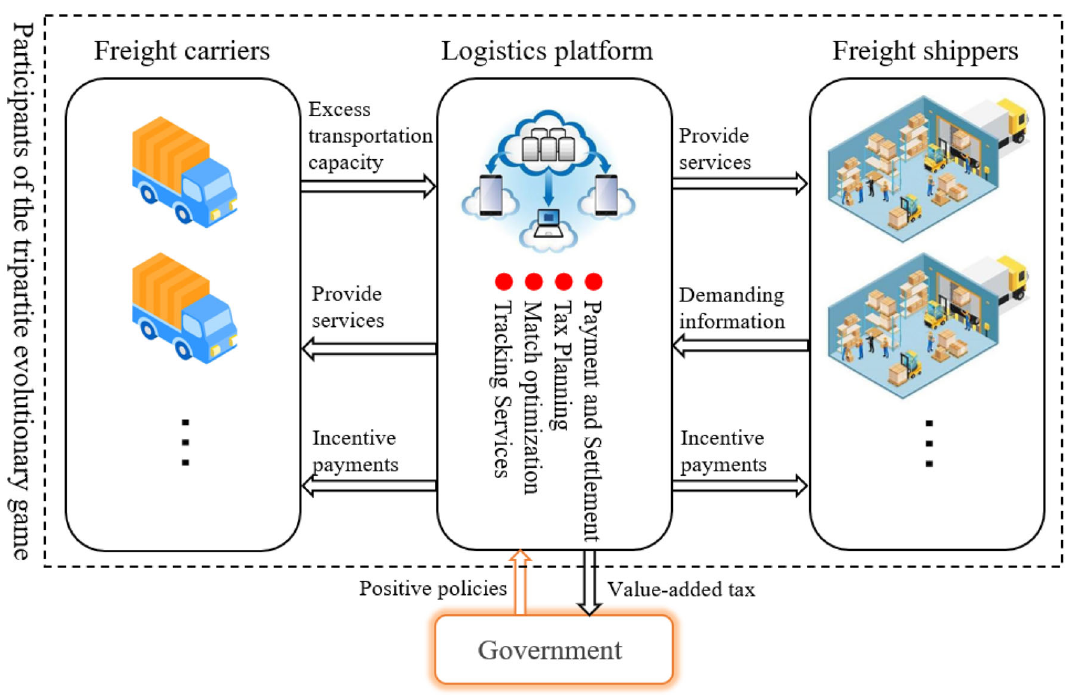
Fig. 1 Working mechanism of the logistics platform